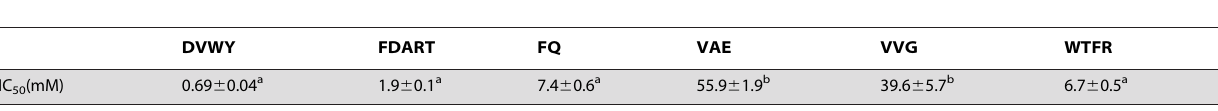
DVWY FDART FQ VAE VVG